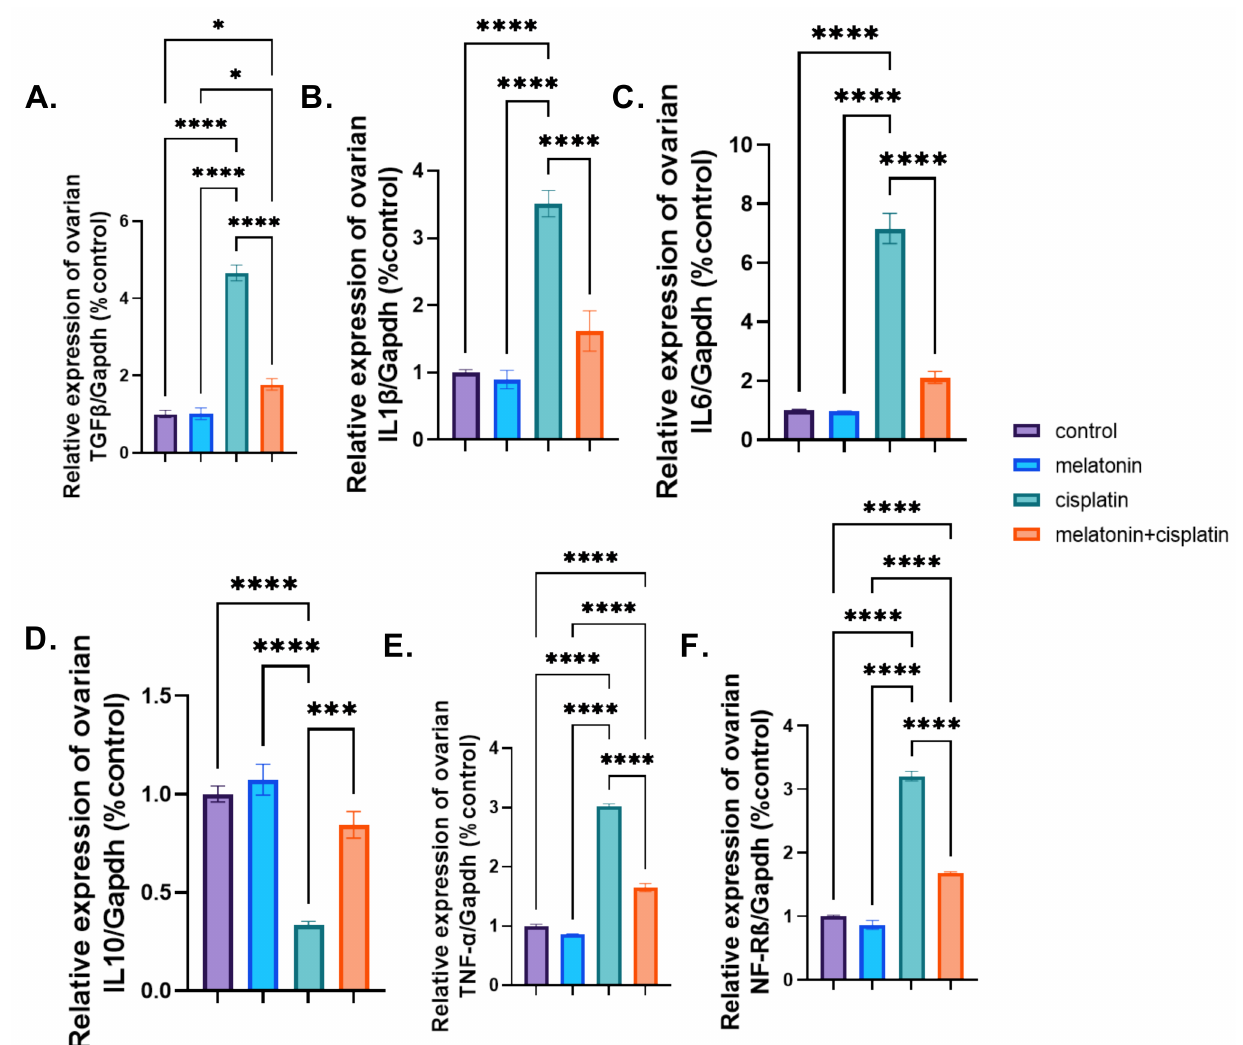
Figure 11. Effect of melatonin administration in cisplatin-induced ovarian impairment in female rats on mRNA expression of ovarian proinflammatory and anti-inflammatory marker genes ( A – F ). ( A ) Ovarian TGF- β 1/ Gapdh (% control), ( B ) ovarian IL1 β / Gapdh (% control), ( C ) ovarian IL6/ Gapdh (% control), ( D ) ovarian IL10/ Gapdh (% control), ( E ) ovarian TNF- α / Gapdh (% control), and ( F ) ovar- ian NF-K β / Gapdh (% control). Data are expressed as means ± SEM. n = 8. *, ***, **** indicate significant difference ( p < 0.05, p < 0.001, and p <